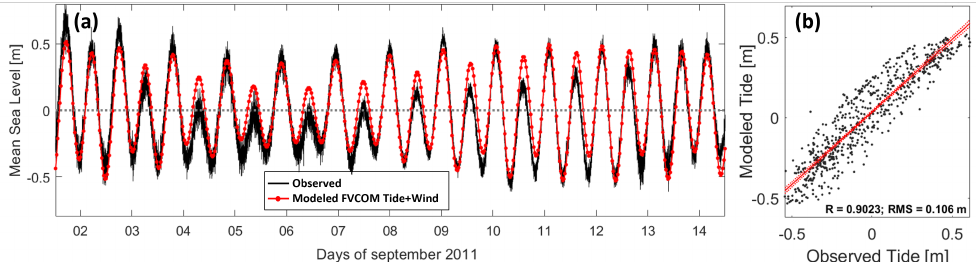
Figure 7. Comparison between sea level time series of at Cumberland Bay (SHOA) and model output of FVCOM Tide + Wind. ( a ) Compared time series and ( b ) correlation analysis.